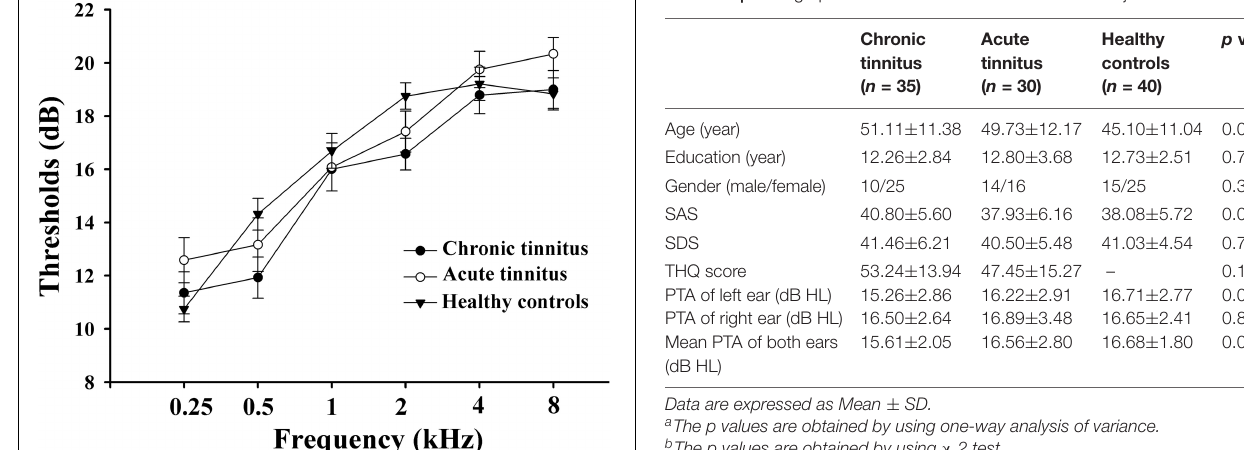
TABLE 1 | Demographic and clinical characteristics of all